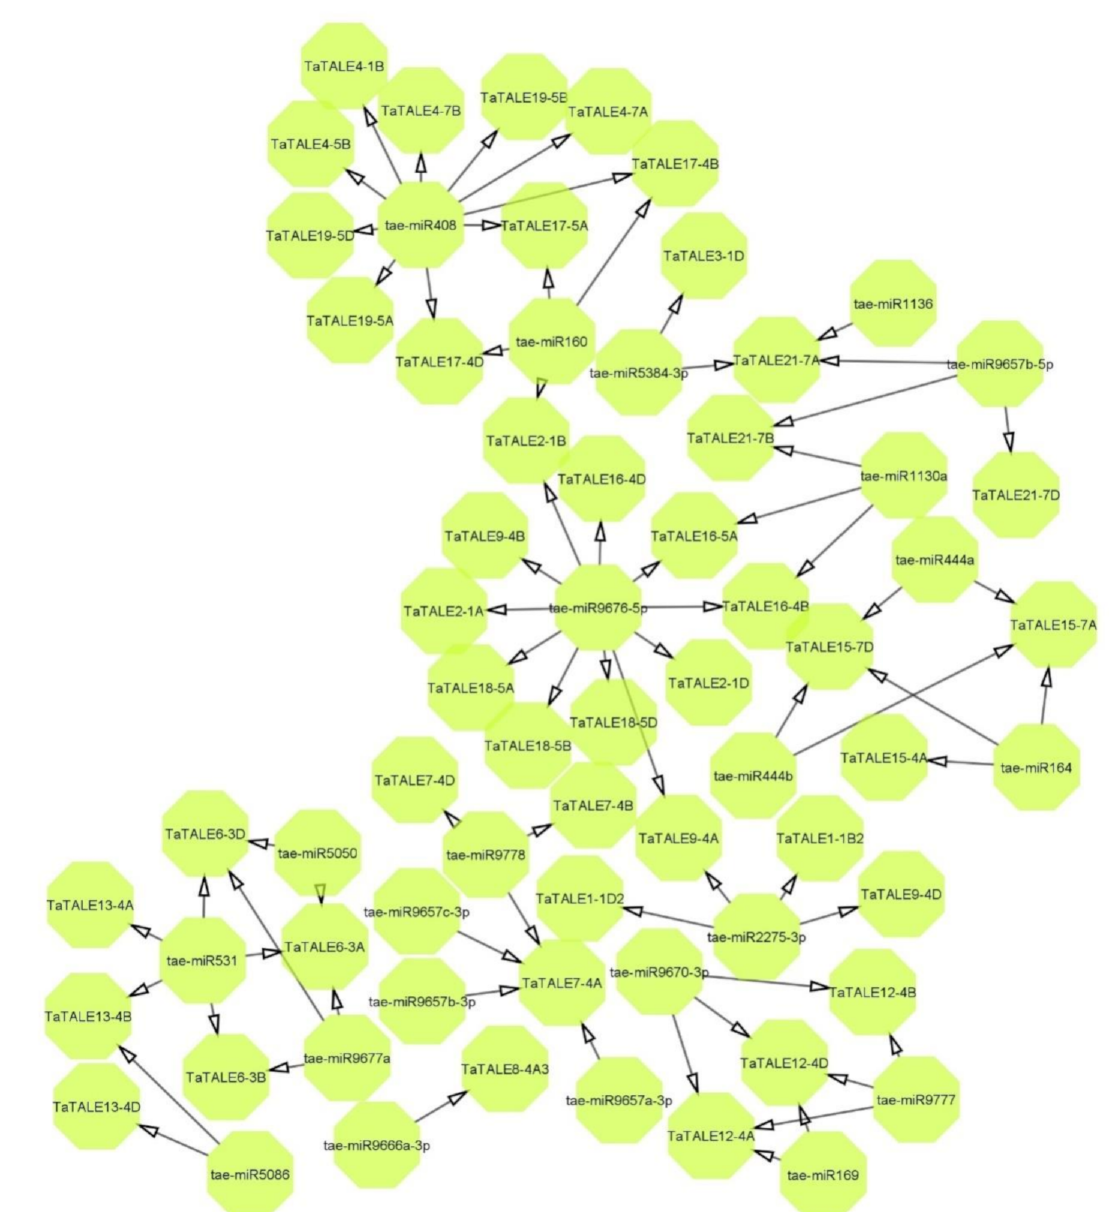
Figure 6. The interaction network of known miRNA of bread wheat ( T. aestivum ) with TaTALE genes. The prediction and generation of the network were performed by the psRNAtarget tool and Cytoscape software,